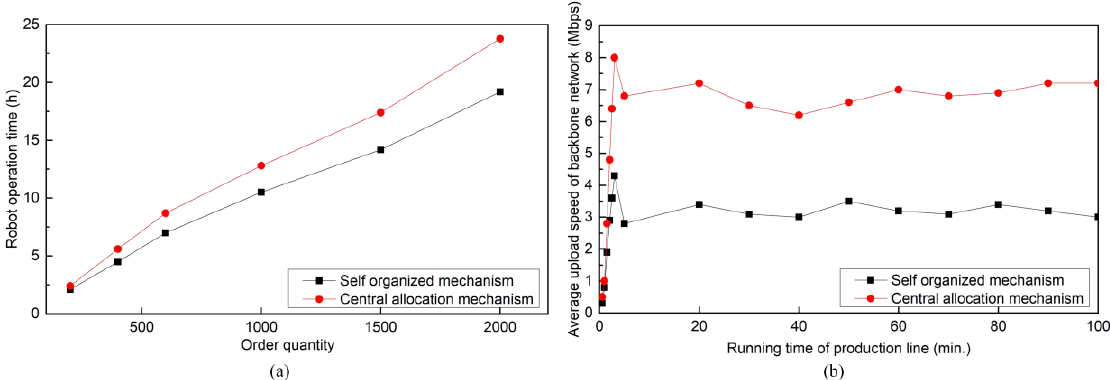
Figure 12. Experimental comparison of the task allocation mechanisms using indicators: ( a ) operation time; ( b ) average upload speed.